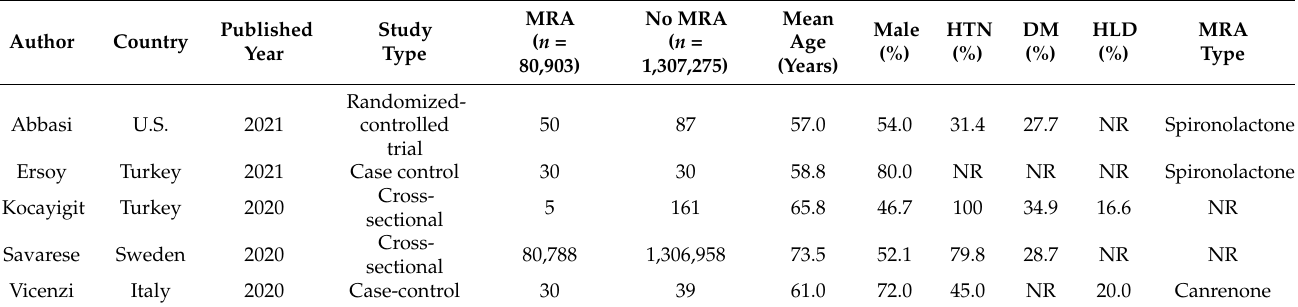
Table 1. Main characteristics of the included studies ( n = 5).